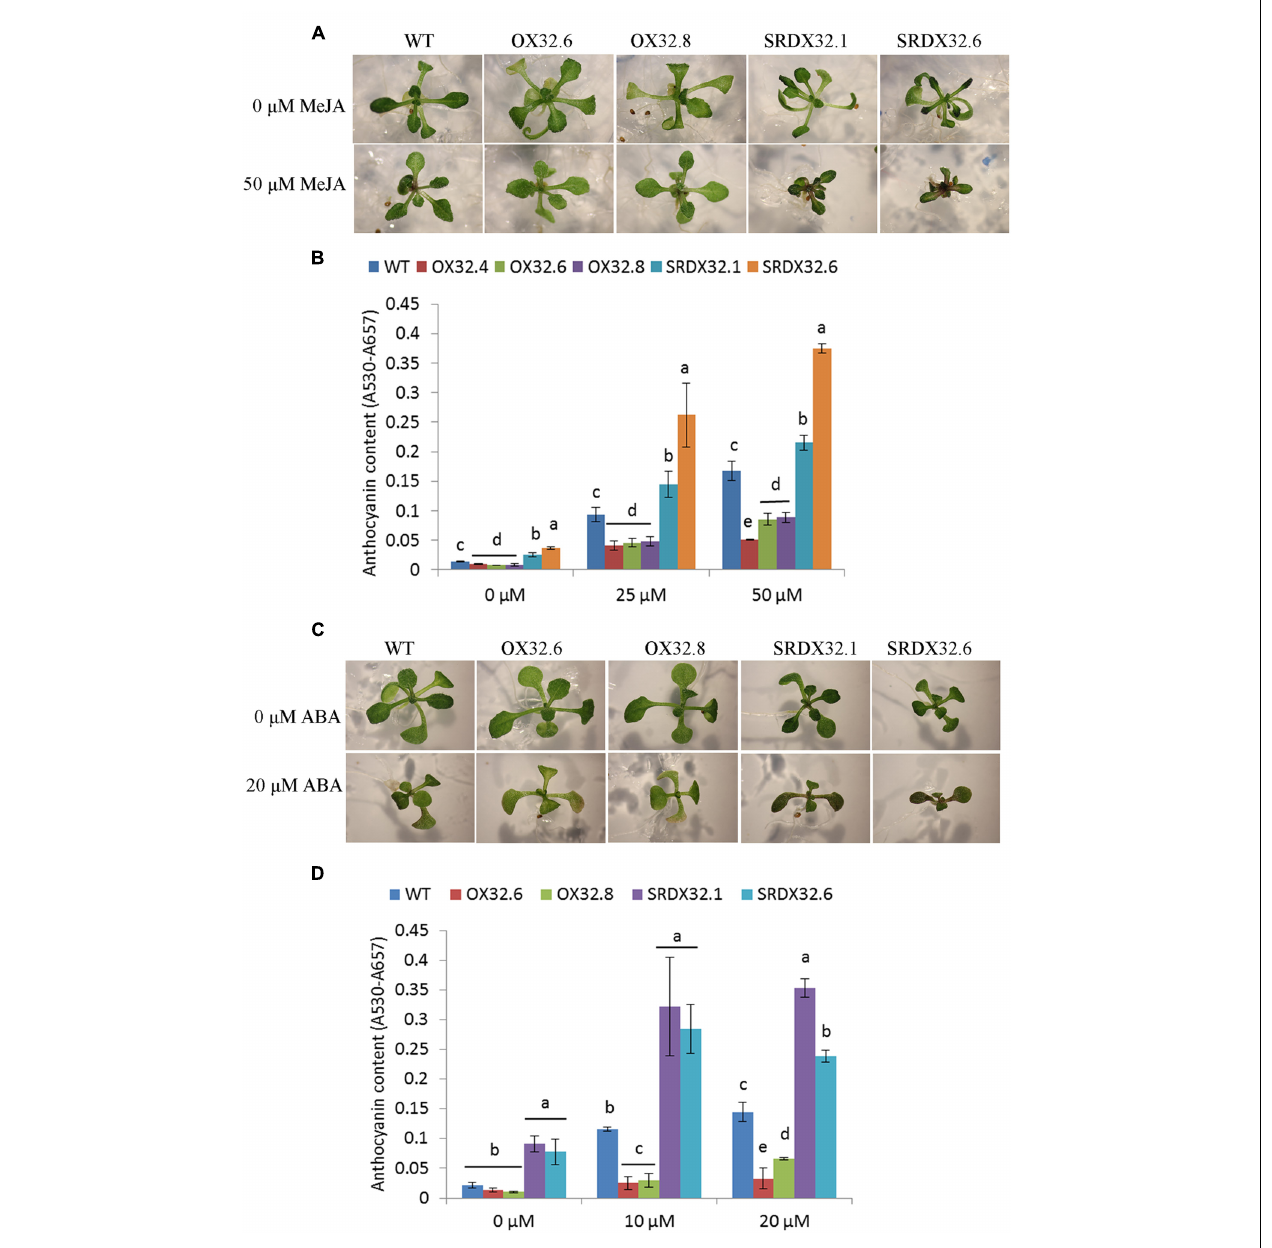
FIGURE 5 | Hormonal regulation of anthocyanin accumulation. (A) Phenotypic response of WT and ANAC032 transgenic lines for anthocyanin biosynthesis in response to MeJA treatment after 15 days of growth under long-day conditions. (B) Anthocyanin content in response to MeJA treatment. Seeds were germinated and grown on half-strength MS agar plates (1% sucrose) supplemented with 0, 25, and 50 µ M MeJA for 12 days under long-day conditions. Twenty seedlings were pooled in each replicate for each genotype to analyze anthocyanin content. (C) Phenotypic response of WT and ANAC032 transgenic lines for anthocyanin biosynthesis in response to ABA treatment. (D) Anthocyanin content in response to ABA treatment. Eight-day-old seedlings of wild-type and ANAC032 transgenic lines were exposed to 0, 10, and 20 µ M ABA and were grown under long-day condition for 4 days. Eight seedlings were pooled in each replicate for each genotype. Data represent mean values ( ± SD, n = 3). Within each treatment, bars with different letters in (B,D) are not similar to each other statistically according to one way ANOVA LSD test ( P < 0.05).